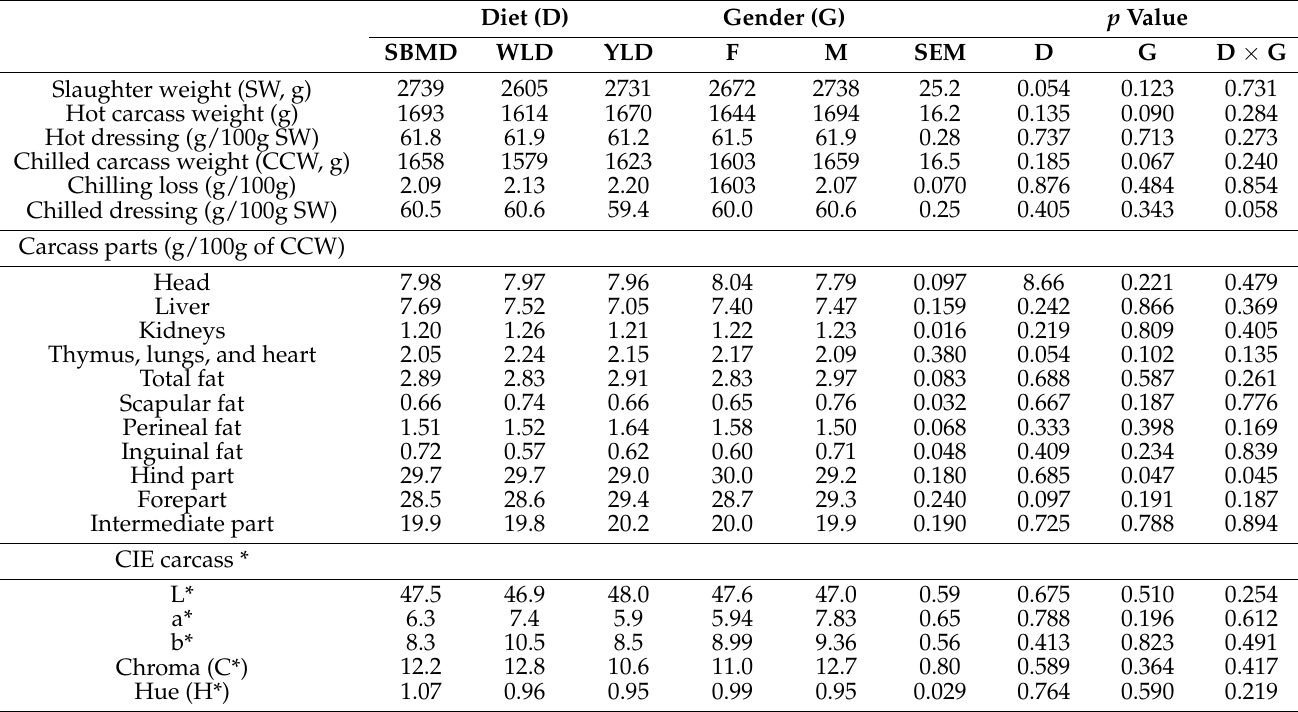
Table 2. Effects of diet and gender on the carcass characteristics of 69-day-old rabbits ( n = 10 per